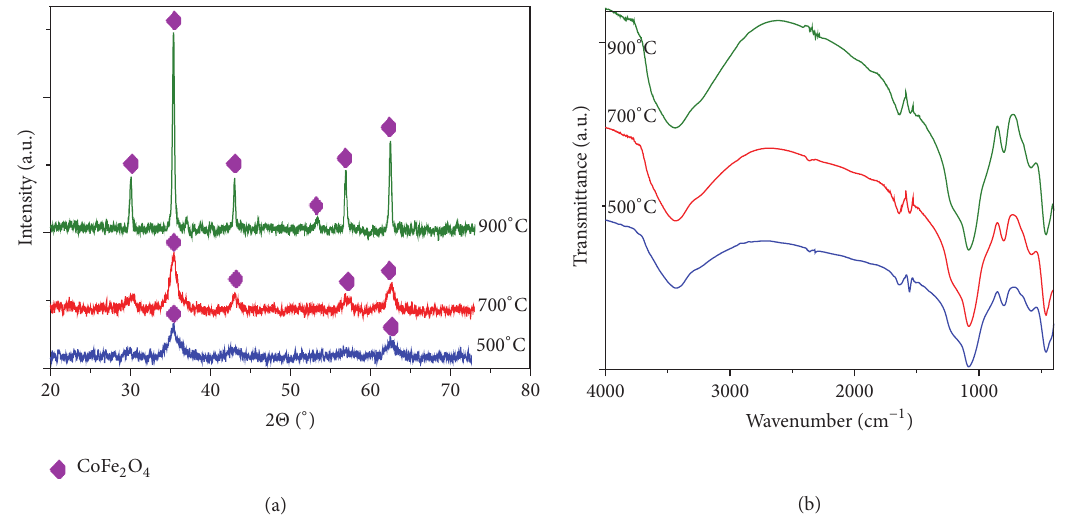
Figure 3: XRD patterns (a) and FT-IR spectra (b) of the gels obtained using 1,3-PD, annealed at 500, 700, and 900 ∘ C.